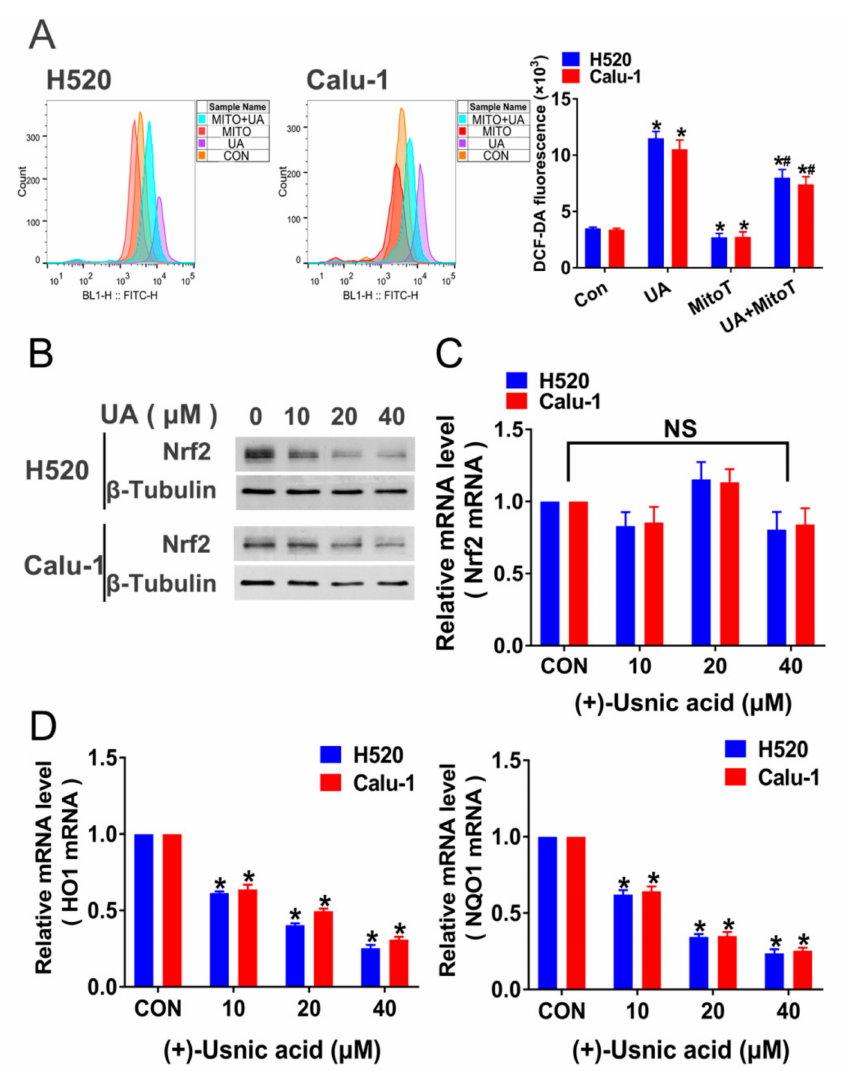
Figure 4. Inhibition of Nrf2 expression mediates ( + )-usnic acid (UA)-induced LUSC cell apoptosis. ( A ) Administration of mitochondria-targeted antioxidant, Mito-TEMPOL (MitoT) to UA-treated H520 and Calu-1 cells. The e ff ect of MitoT on ROS production was detected by flow cytometry. Significantly di ff erent from control group, * p < 0.05, n = 3; # significantly di ff erent from the group of UA, p < 0.05, n = 3. ( B ) UA (10 to 40 µ M) suppressed Nrf2 expression in H520 and Calu-1 cells analyzed by Western blotting after 8-h incubation. ( C ) The e ff ect of UA on Nrf2 mRNA expression in H520 and Calu-1 cells assayed by q-PCR. NS, not significantly, p > 0.05, n = 3. ( D ) The e ff ect of UA on the mRNA expression of Nrf2-targeted genes (HO1 and NQO1) in H520 and Calu-1 cells determined by q-PCR. Significantly di ff erent from control group, * p < 0.05, n =